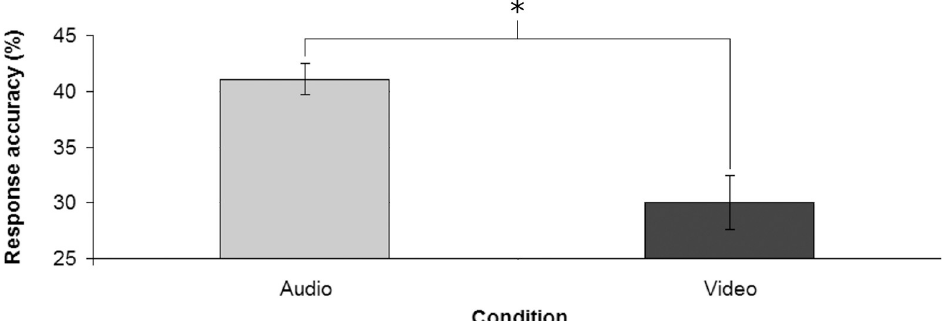
Fig 8. Response accuracy in the two conditions. Error bars show the standard error of the mean; � denotes statistical significance.